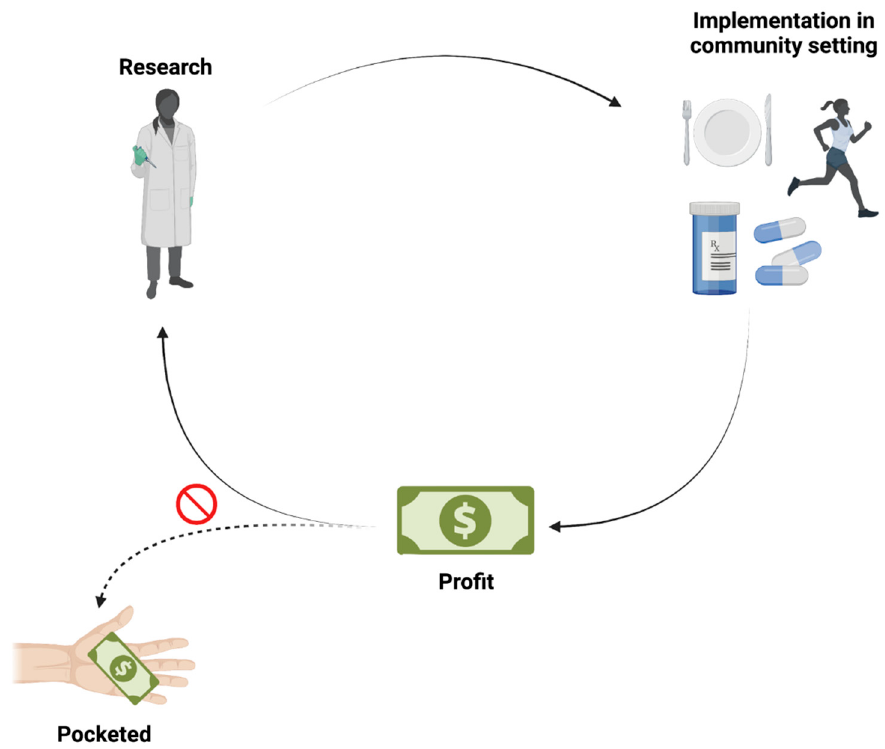
Figure 2. The dilemma. A broadly applicable scientific wellness model (i.e., across healthspan/lifespan) that balances both profit and a focus on generating high-quality research has yet to be implemented in the community. Striking such a balance would seem to be the necessary target in terms of affordable scientific wellness based on rigorous, quantitative research. As depicted in the figure, when profit is only partially reinvested into the research, quantitative science and effective implementation in the community are at